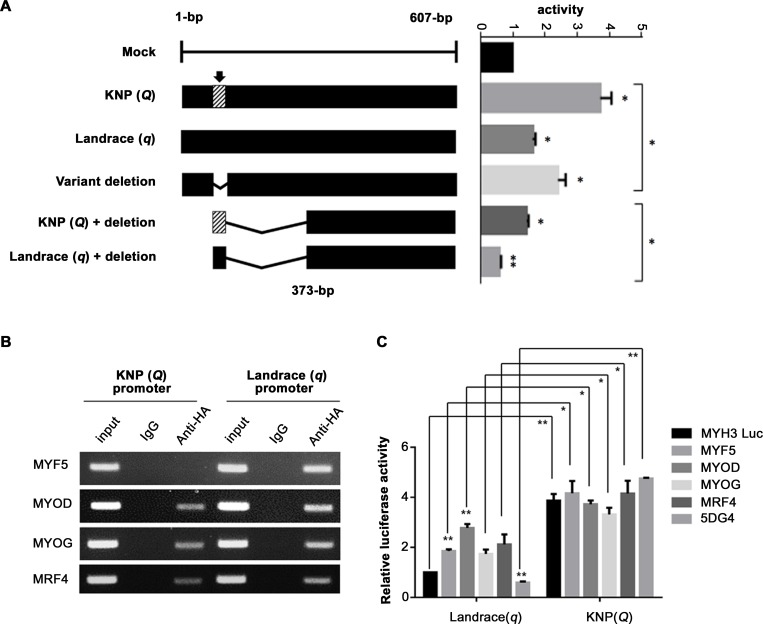
Analysis of promoter activity and transcription factor binding site in porcine fibroblast cells.(A) Schematic overview of the XM_013981330.2:g.−1805_−1810del luciferase reporter constructs and the results of the promoter activity assay. The arrow represents the sequence segment location of the XM_013981330.2:g.−1805_−1810del. Data histograms and error bars represent the mean±standard error of triplicate independent samples. *P<0.05, **P<0.01. (B) ChIP assay of the binding of MRFs to the XM_013981330.2:g.−1805_−1810del promoter region in porcine fibroblast cells derived from KNPs (Q) and Landrace (q). (C) Results from cotransfection experiments in porcine fibroblast cells. The MYH3 q promoter acts as a stronger repressor than the MYH3 Q promoter. The 5DG4 represents a cotransfection experiment with all four MRFs. Data histograms and error bars represent the mean±standard error of triplicate independent samples. *P<0.05, **P<0.01.